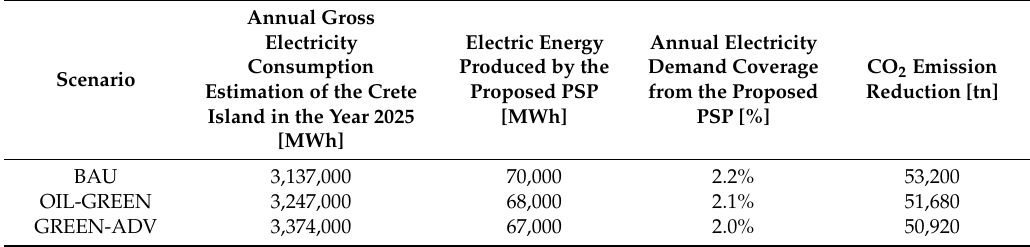
Table 6. The proposed PSP contribution in the gross electricity consumption coverage and in the CO 2 emission